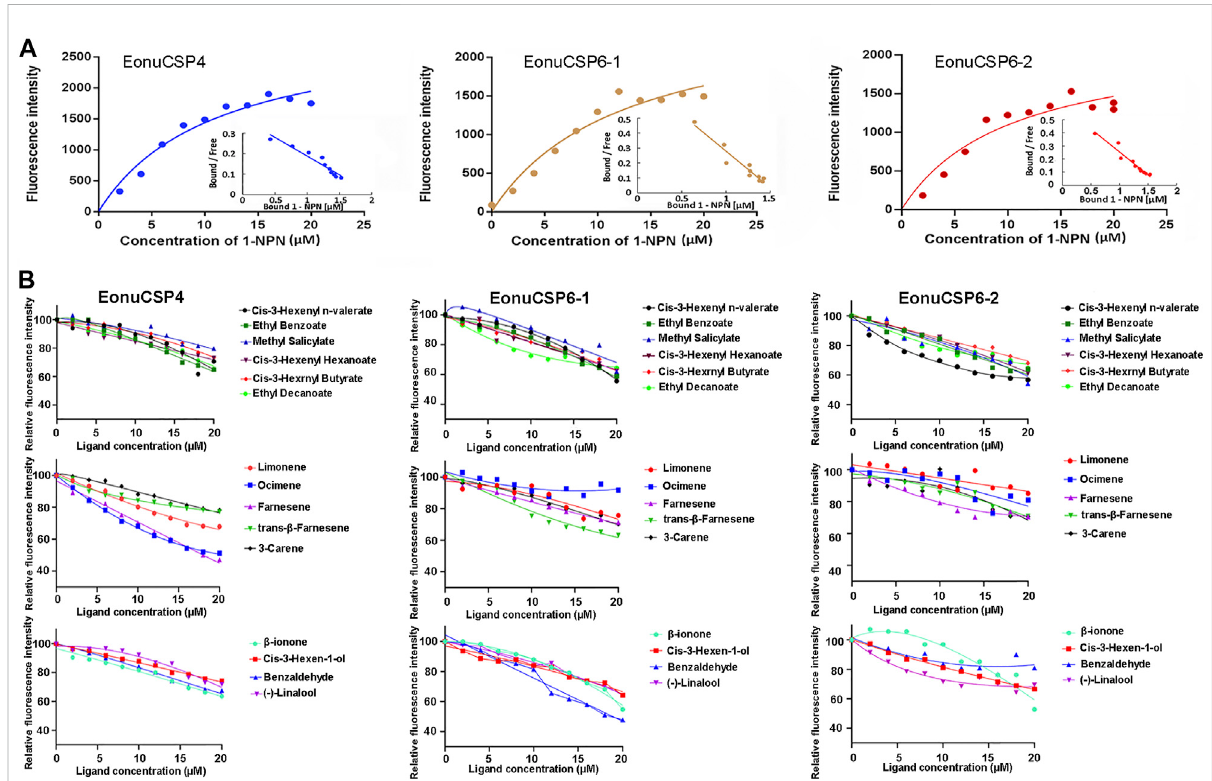
Fluorescencecompetitiveligand-bindingassaysofEonuCSPs. (A) .BindingcurveandtheScatchardplotofN-phenyl-1-naphthylamine(1-NPN) to EonuCSP4, 6-1 , and 6-2 respectively. (B) . Competitive binding curves of EonuCSP4, 6-1 , and 6-2 with various ligands including ester substances (Cis-3-Hexenyl n-valerate, Ethyl Benzoate, Methyl Salicylate, Cis-3-Hexenyl Hexanoate, Cis-3-Hexrnyl Butyrate, and Ethyl Decanoate), alkene substances (Limonene, Ocimene, Farnesene, trans- β -Farnesene, and 3-Carene), and aldehydes, ketones and alcohols [(-)-Linalool, Cis-3- Hexen-1-ol, β -ionone, and Benzaldehyde]. Dissociation constants ( K i ) of all examined ligands were evaluated. Low K i values mean high binding af fi nity for protein and the plant volatiles.